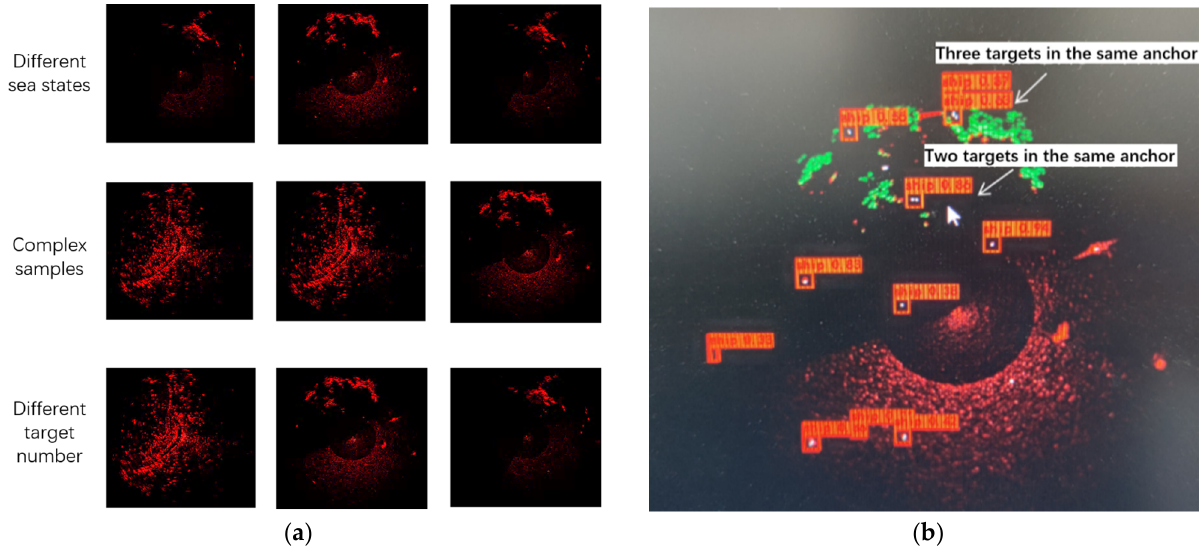
Figure 11. Characterizations of the radar PPI images dataset: ( a ) Examples of a navigation radar PPI image; ( b ) Multiple targets in the same anchor box.